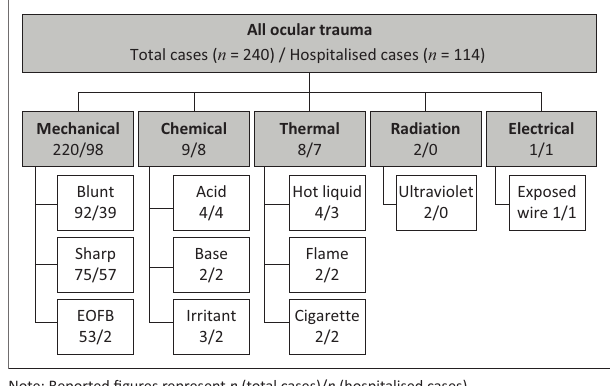
FIGURE 3: Mechanism of injury responsible for ocular trauma in all participants ( n = 240) and hospitalised participants ( n =